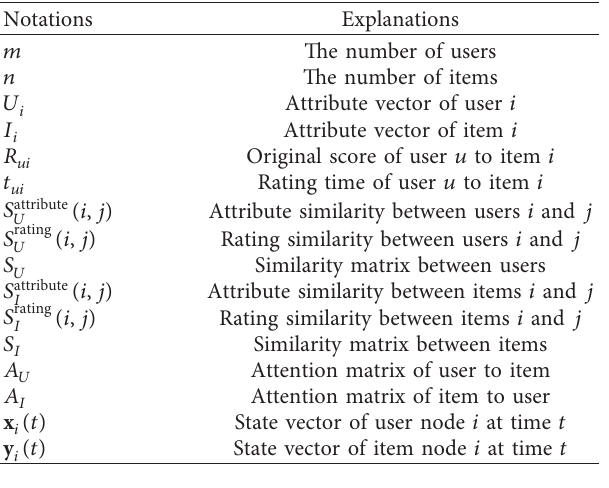
Table 1: Notations and explanations.